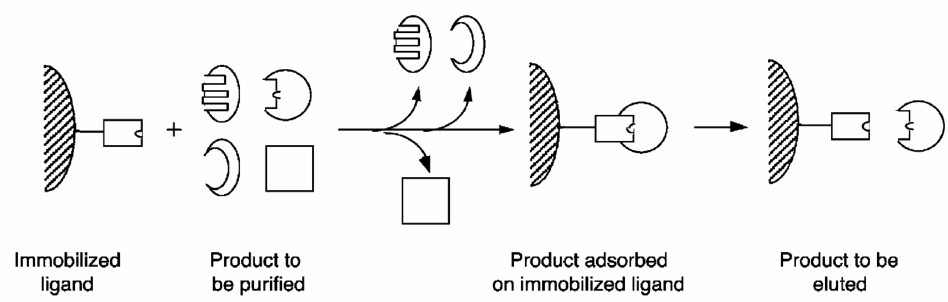
Figure 8. Principle of dye-ligand chromatography. Reprinted by permission from [62]. Copyright 2001